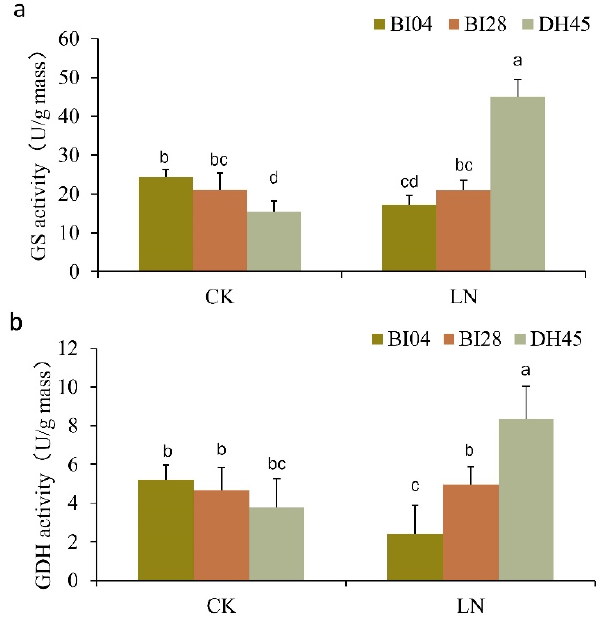
Figure 9. Activity of two enzymes in the leaves of DH45 and its parents after 7d of LN treatment. ( a ). GS activity; ( b ). GDH activity. Different lowercase letters indicate significant differences ( p < 0.05) between DH45 and parents by Fisher’s least significant difference (LSD) test. The error bars are shown from the analysis of five biological replicates.